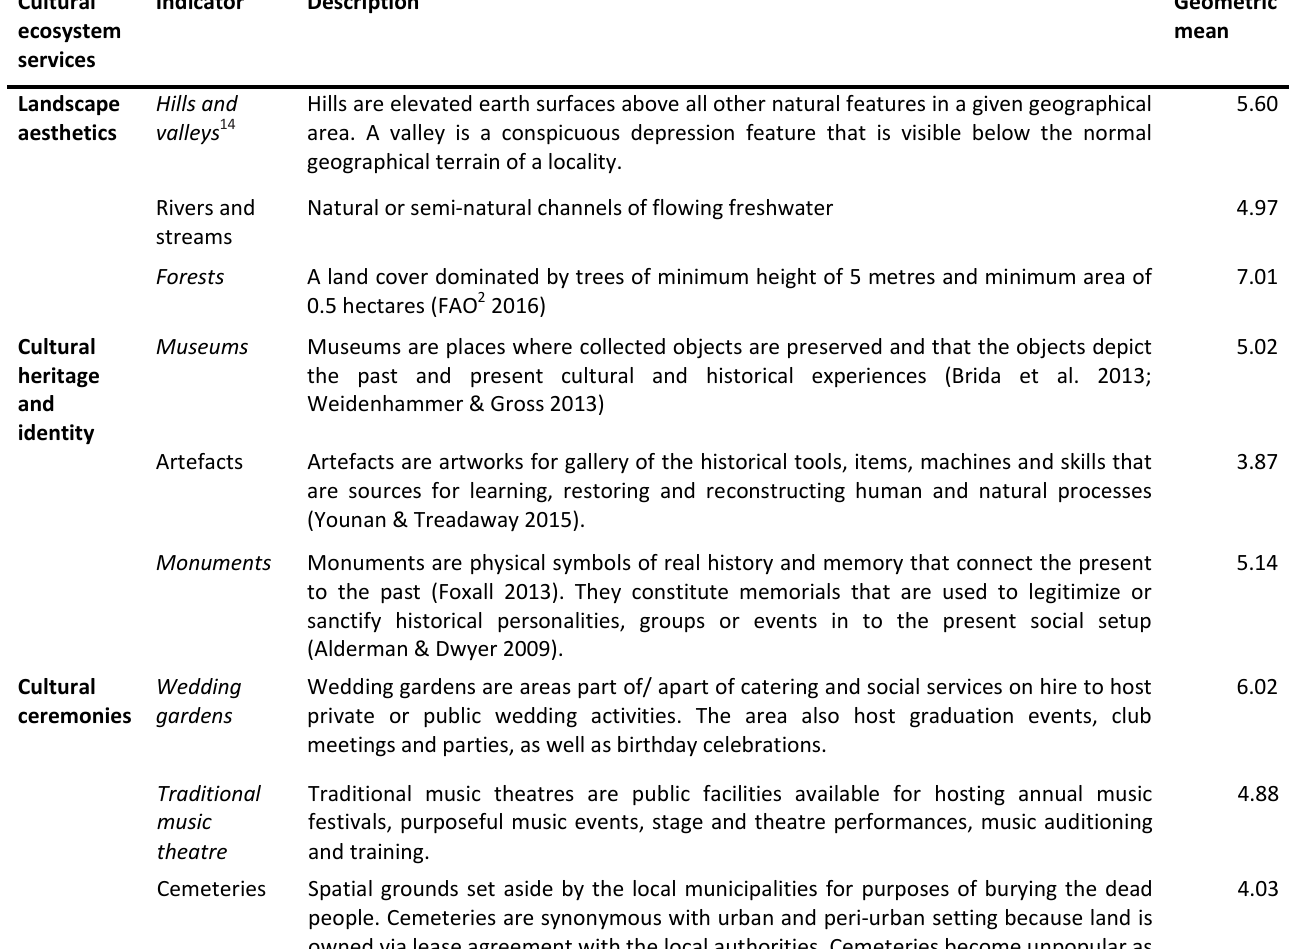
Table 2: Five selected cultural ecosystem services and ranking of respective indicators (n=17)